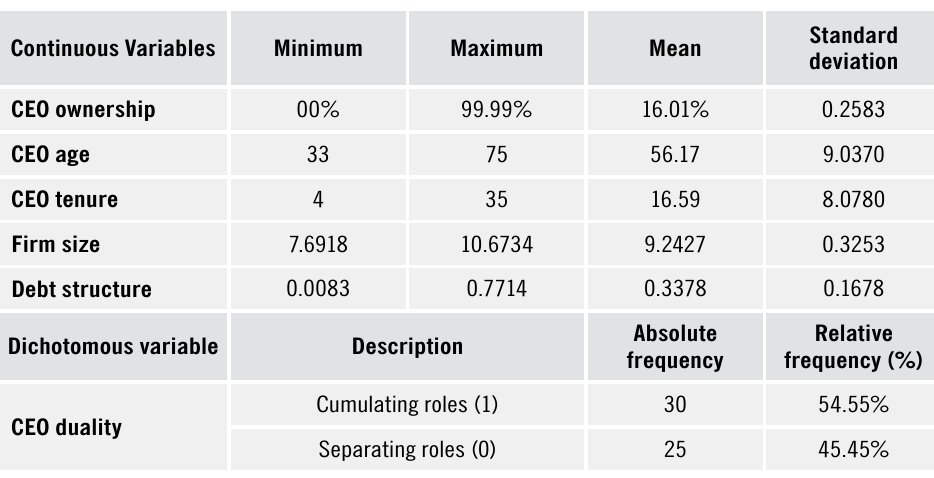
Table 4. Descriptive